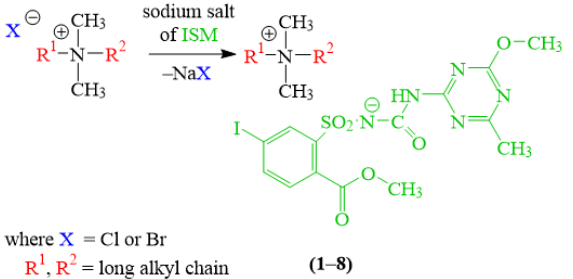
Scheme 1. Method of preparation of iodosulfuron-methyl-based salts with commercial tetraalkylammonium cations ( 1 – 8 ).